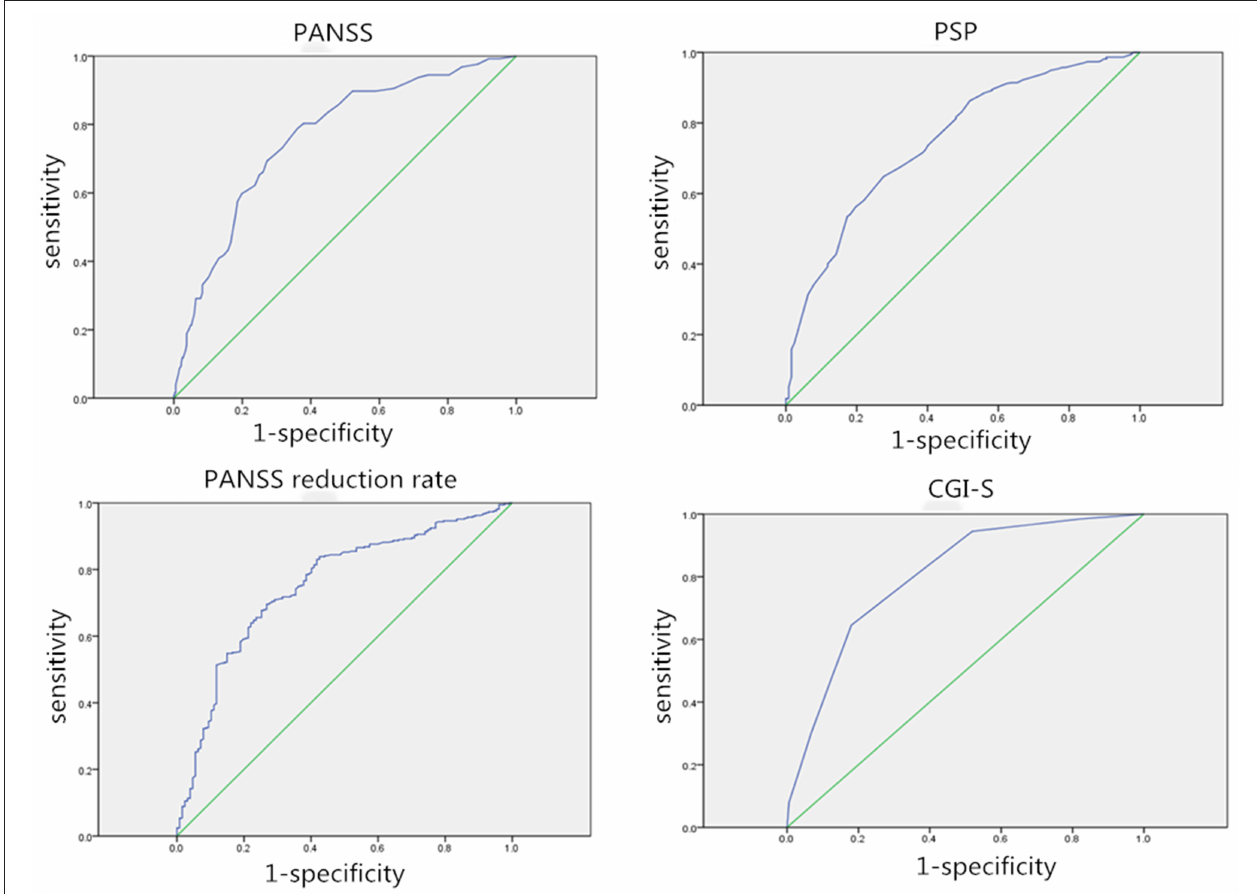
FIGURE 1 | Receiver operating characteristic (ROC) curves for each outcome assessment. AUC, Area under the curve; ROC curve, receiver operating characteristic